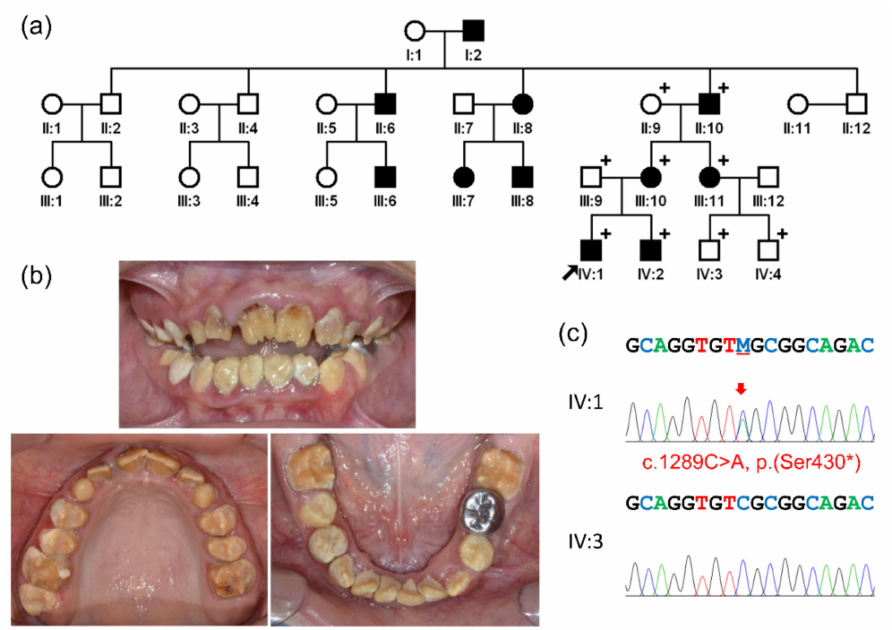
Figure 1. Pedigree, clinical photos and sequencing chromatograms: ( a ) pedigree of the family. Affected family members are indicated by black-filled symbols and the participating members are indicated with a plus sign (+) at the upper right corner of the symbols. The black arrow indicates the proband. ( b ) Clinical photos of the proband at age 10 years 6 months. A brown-discolored, rough enamel surface can be seen in all teeth. Heavy calculus deposits and an anterior open bite can be observed. ( c ) Sequencing chromatograms are shown for the proband (IV:1) and an unaffected cousin (IV:3). The mutation is indicated by the red arrow (M: C and